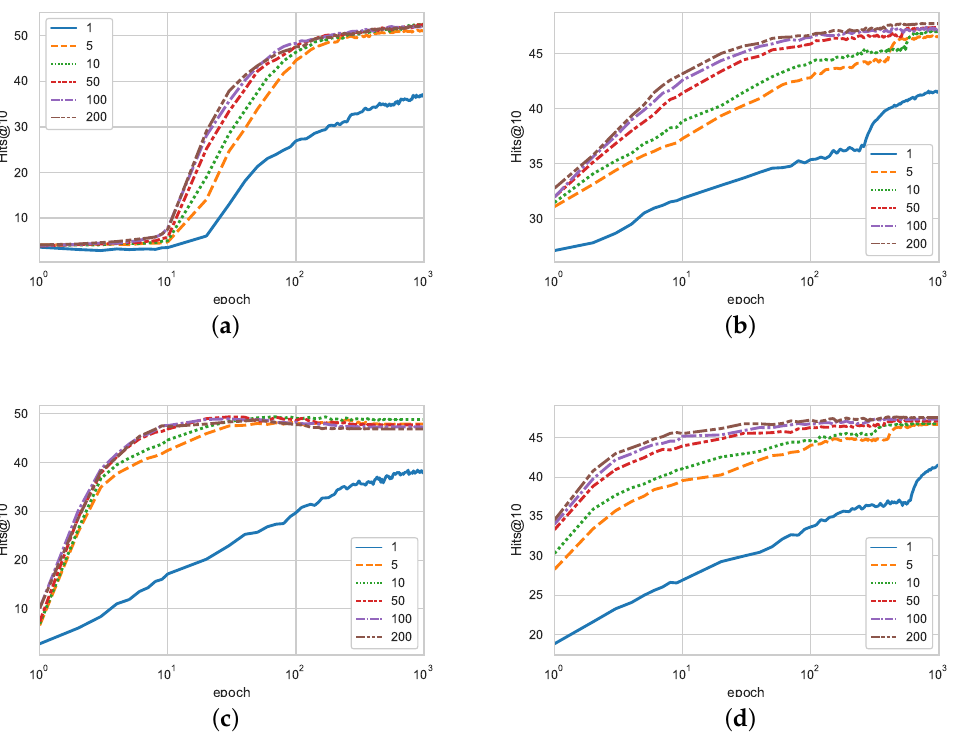
Figure 2. Hit@10 performances according to various numbers of negative triples. ( a ) WN18RR—TransE, ( b ) FB15K-237—TransE, ( c ) WN18RR—TransD, ( d )